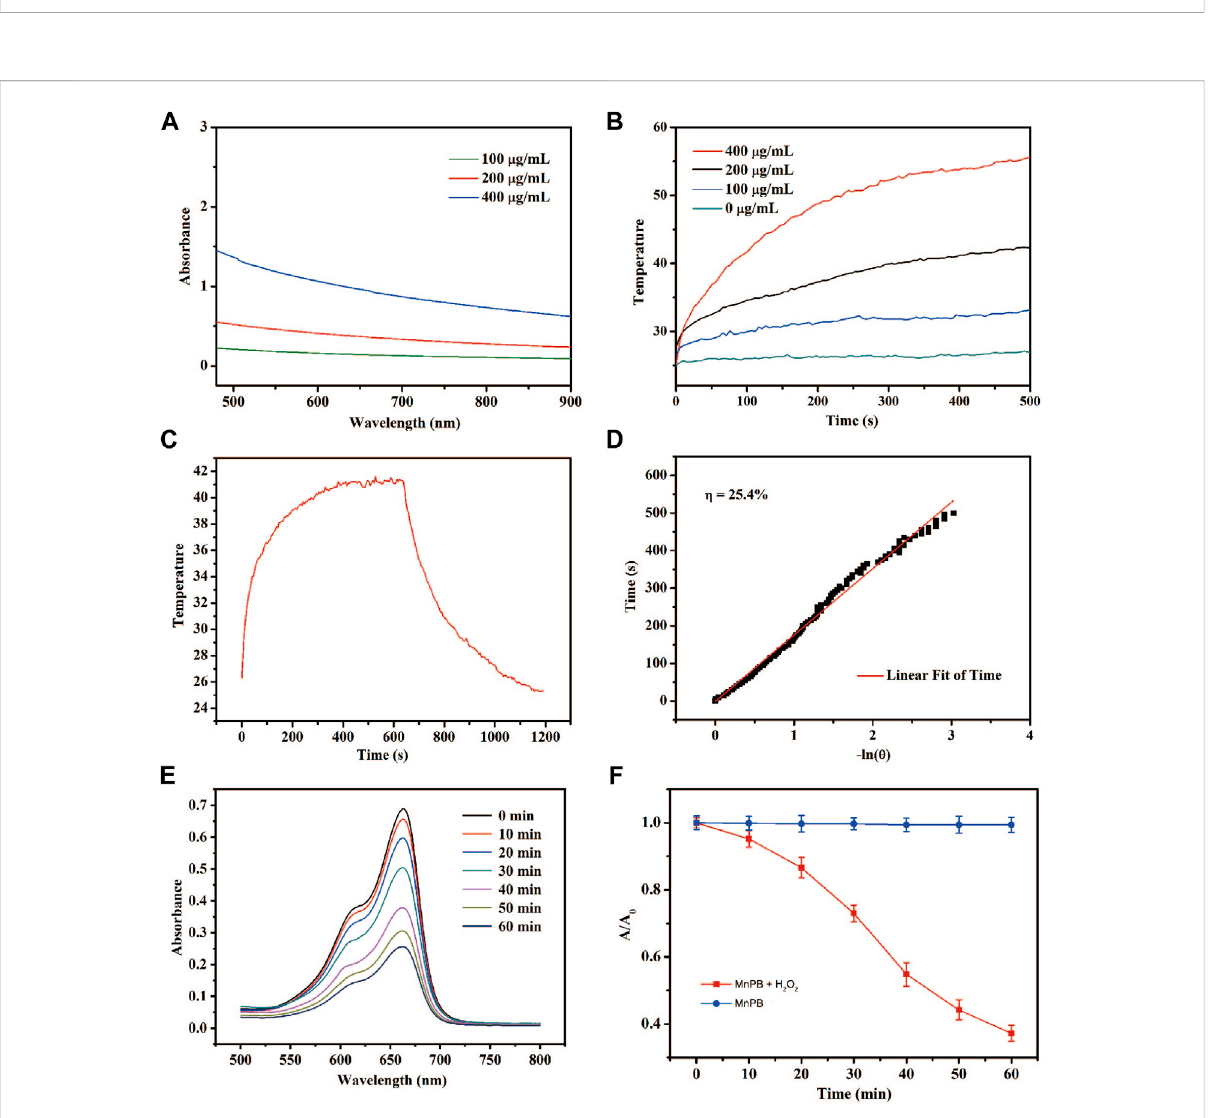
The photothermal properties of the MnPB NPs (A) UV-Vis-NIR absorption spectra of MnPB NPs. (B) Temperature pro fi les of MnPB NPs at different concentrations under laser irradiation (C) The temperature changes of MnPB NPs (irradiation heating and natural cooling) at 200 μ g/ml concentrations (D) linear regression for the naturing cooling process. (E) Degradation of MB with the treatment of MnPB NPs and H 2 O 2 . (F) Absorption of MB in two groups at 664